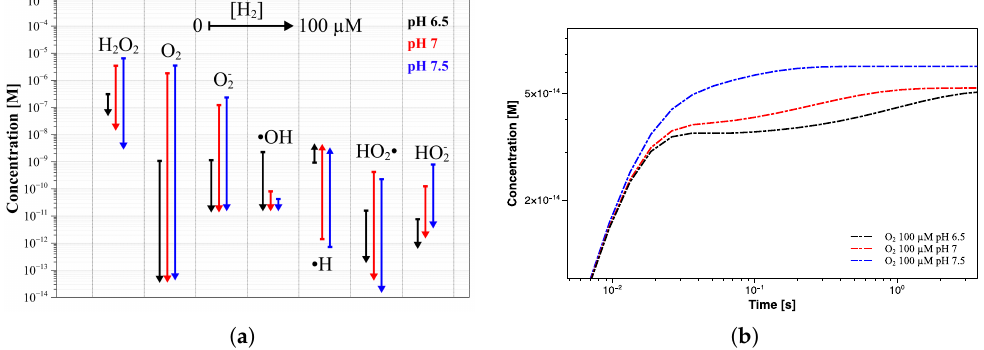
Figure 10. ( a ) Concentration trend of the main radiolytic products after 1 year of exposure, as a func- tion of hydrogen addition, at pH 60 6.5 (black lines), 7 (red lines), and 7.5 (blue lines). ( b ) Comparison between the oxygen concentration profiles at pH 60 6.5, 7, and 7.5 when 100 µM of hydrogen is